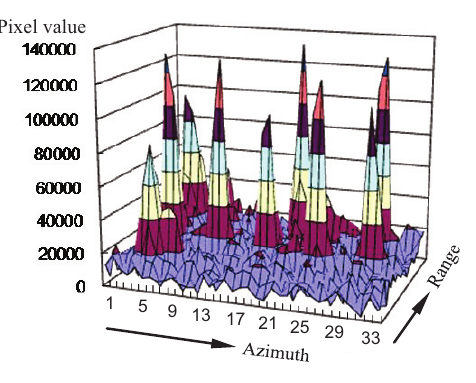
(b) 3D profile in two directions. Figure 5. Profiles around the CRs.